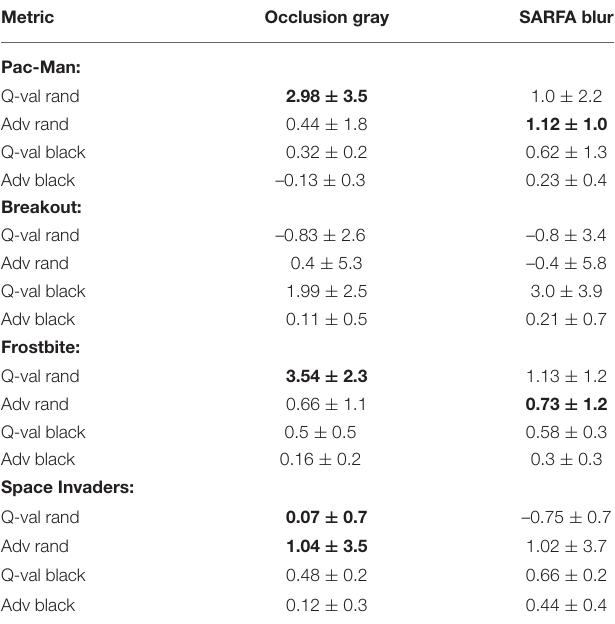
TABLE 9 | The sample mean and SD of the insertion metric curve for our additional experiments with different perturbations for Occlusion Sensitivity and